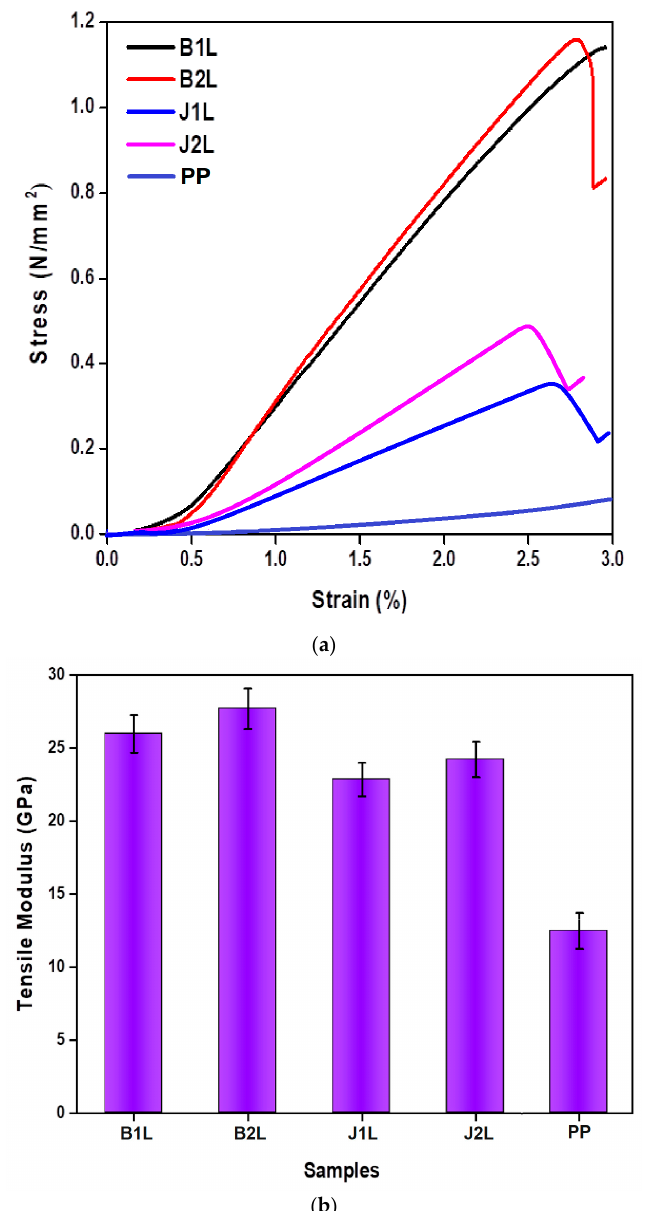
Figure 3. Tensile properties of the composites. ( a ) Stress–strain behavior of the composites vs. the control sample (PP). ( b ) Tensile modulus of the composites vs. the control sample (PP). Fractography